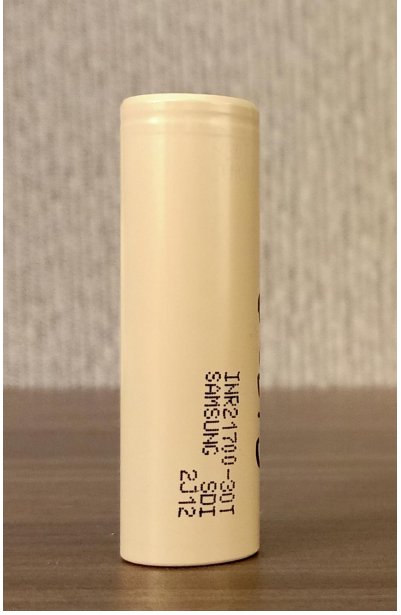
Figure 10. Samsung-30T INR21700 Li-ion